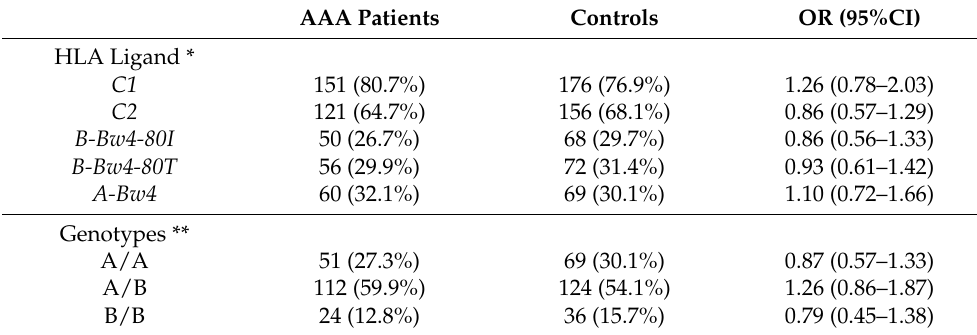
Table 3. Ligands and KIR-genotypes frequency in cases and